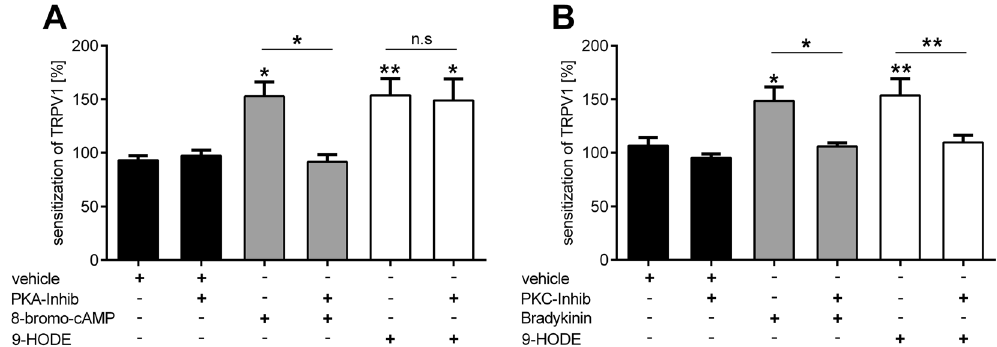
Figure 5. TRPV1 sensitization via 9-HODE-dependent activation of G2A is mediated by PKC but not PKA. ( A ) Sensitization of TRPV1 via 9-HODE (200 nM, 120 s) of adult DRG neurons is not influenced by the PKA-Inhibitor H89 (10 µ M, 45 min before measurement) in calcium imaging experiments. As control for PKA-dependent TRPV1 sensitization 8-bromo-cAMP (40 µ M, 120 s) was used. Data shown as mean ± SEM with n = 20–69 cells per condition. ( B ) The PKC-Inhibitor GF109203X (1 µ M, 45 min before measurement) suppresses the 9-HODE-dependent sensitization of TRPV1. Bradykinin (500 nM, 120 s) was used as positive control for PKC-dependent sensitization of TRPV1. Data is shown as mean ± SEM with n = 45–90 cells per condition; * p < 0.05 ** p < 0.01 one-way ANOVA with Bonferroni post-hoc